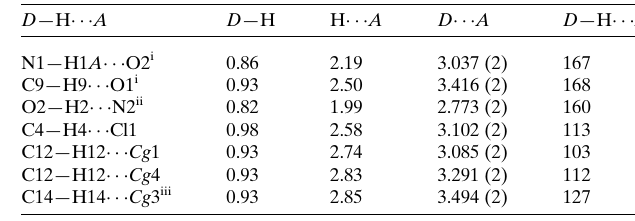
Figure 1 The molecular structure of the title compound, showing the atom- numbering scheme and displacement ellipsoids drawn at the 30% probability level. The intramolecular C4—H4 (cid:3)(cid:3)(cid:3) Cl1 hydrogen bond is drawn as a dashed line.